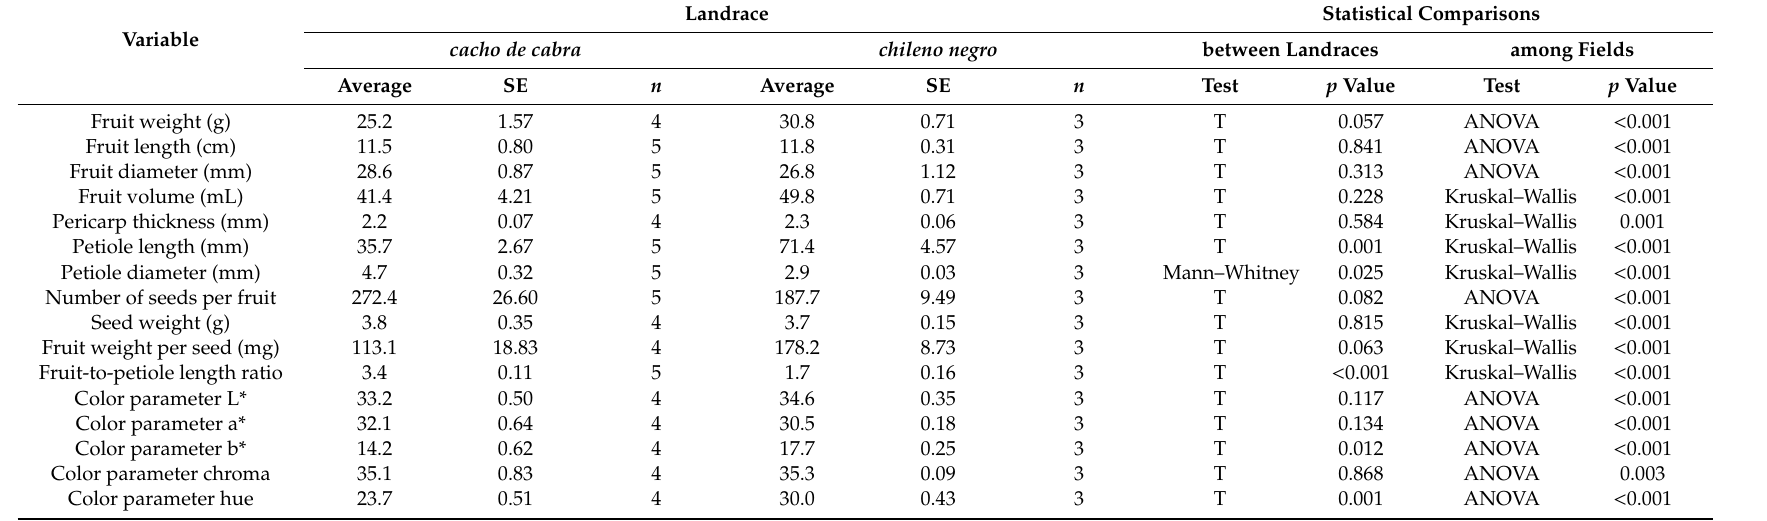
Table 4. Average values for each measured variable in chili pepper fruits of di ff erent fields and landraces.